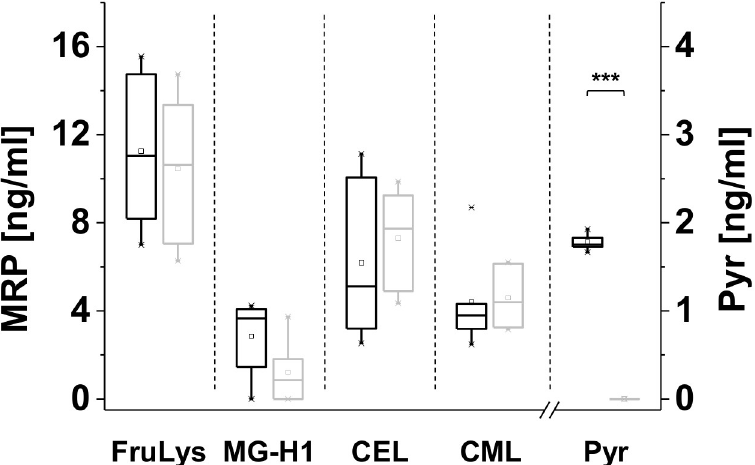
Fig 3. Investigation of an alimentary impact on salivary Maillard reaction compounds. Salivary MRP levels of six subjects following a diet low in Maillard reaction products (MRP) from day 1 (black, left, usual diet) to day 3 (gray, right, two days low MRP diet), presented as box plot. Samples were analyzed in duplicate. Significance: ��� significantly differed with a p-value <